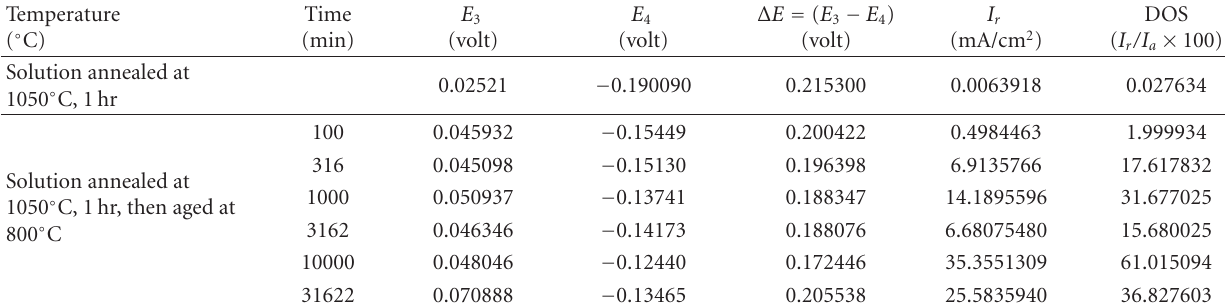
Table 6: DLEPR test results on the reverse scans of polarization